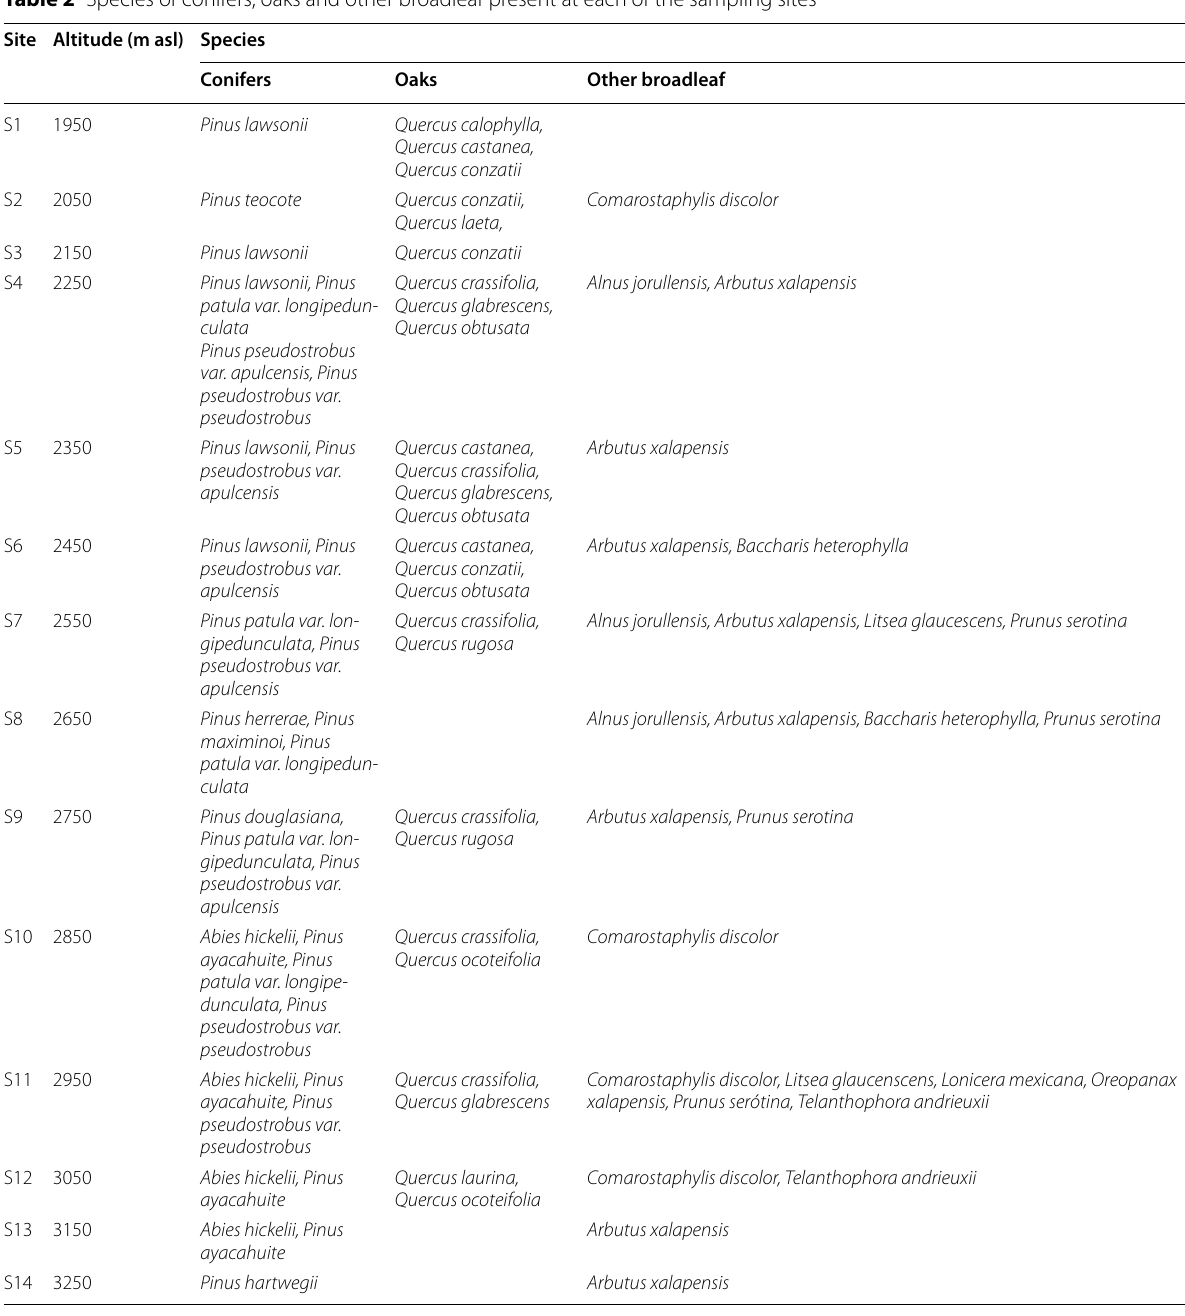
Table 2 Species of conifers, oaks and other broadleaf present at each of the sampling sites Site Altitude (m asl)